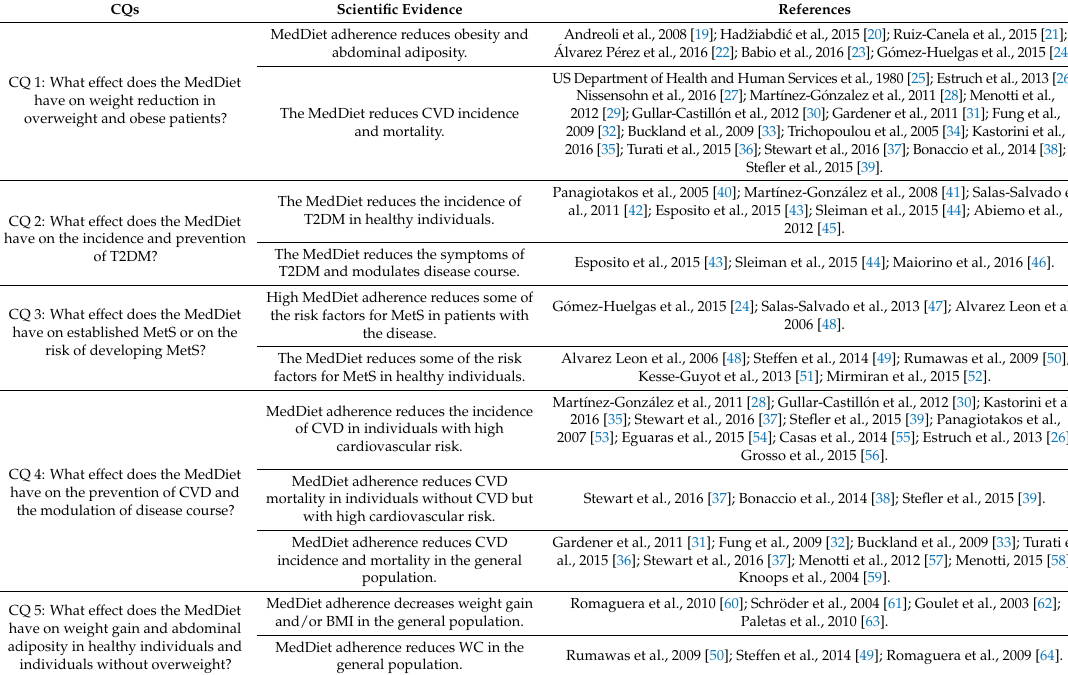
Table 5. Scientific evidence for health outcomes related to the key CQs on the Mediterranean Diet (MedDiet). CQs